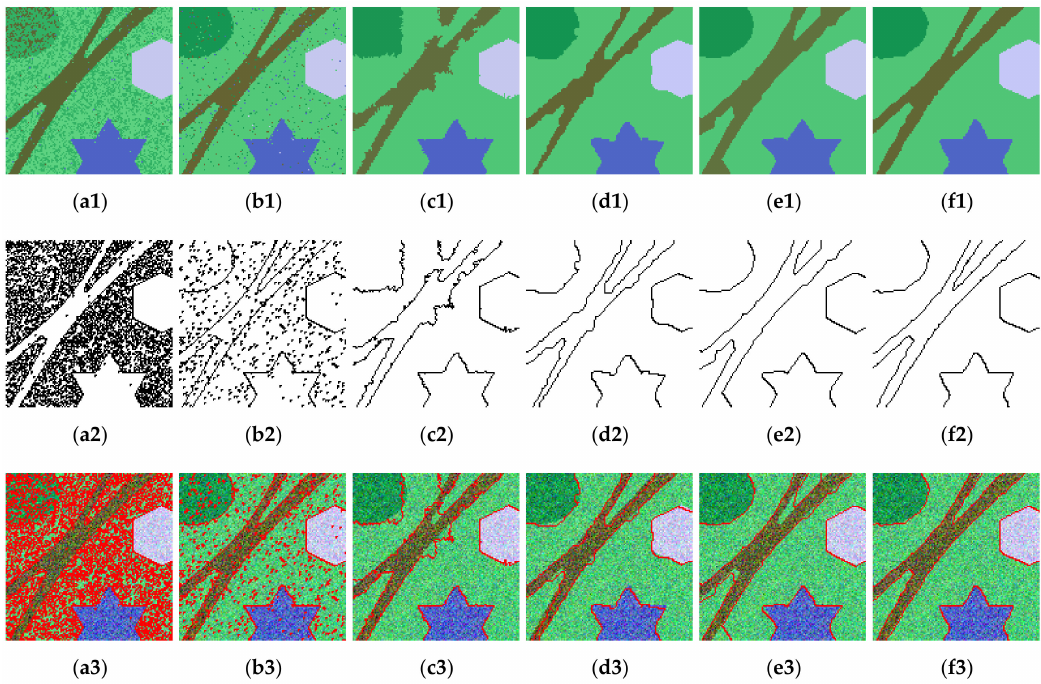
Figure7. Representativesegmentationresultsofsimulatedimage. ( a1 – a3 )FCM_S;( b1 – b3 )HMRF_FCM;